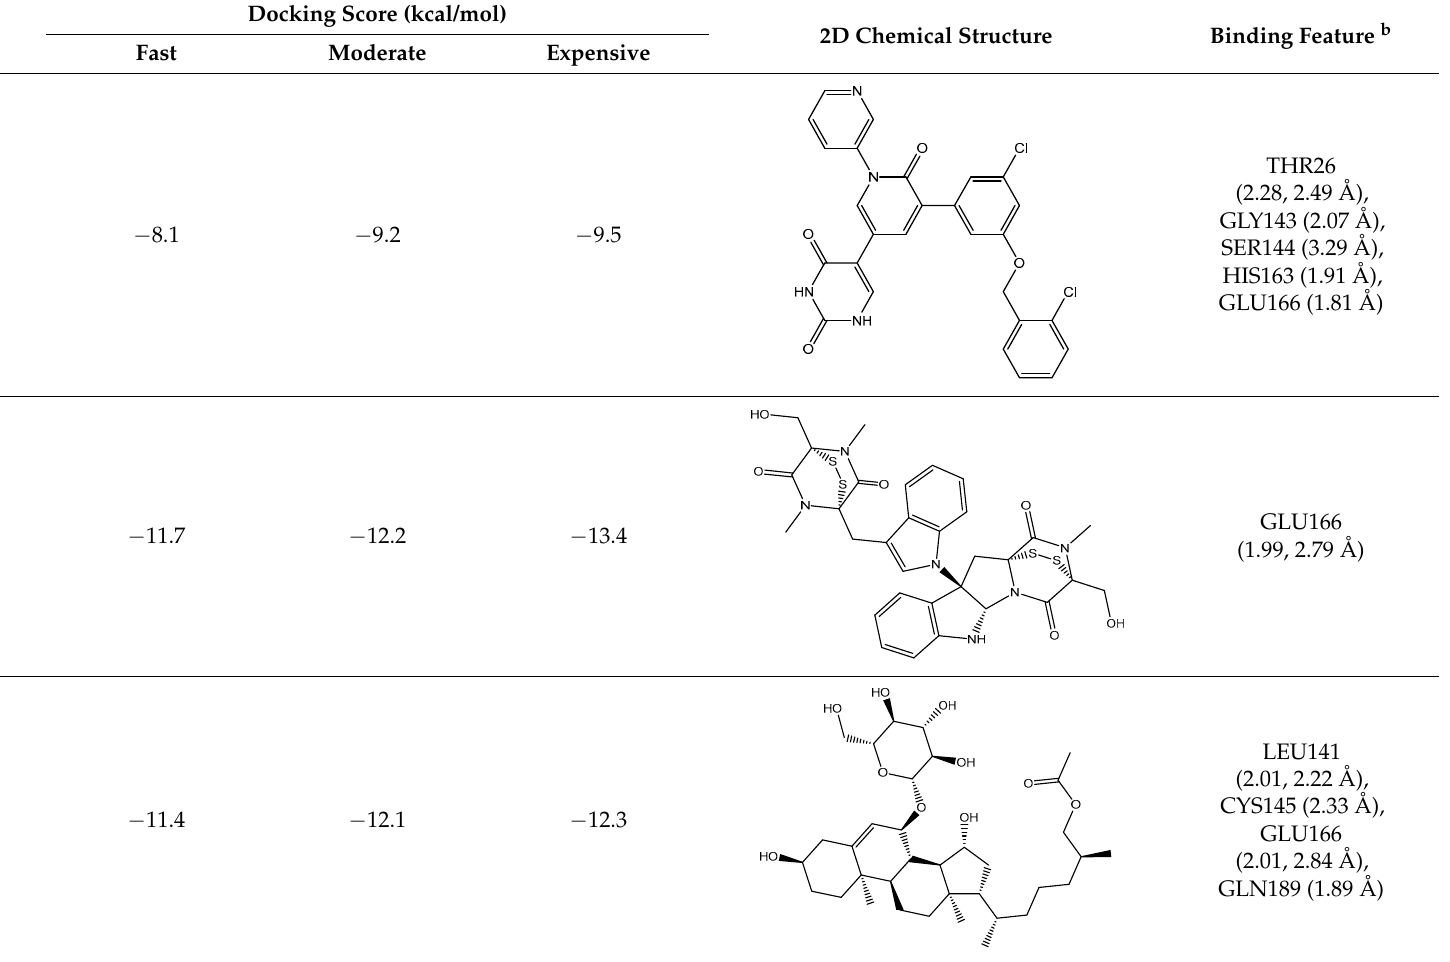
Table 1. Evaluated fast, moderate, and expensive docking scores, binding features, and 2D chemical structures for most potent MNPs against 3CL pro a . No.